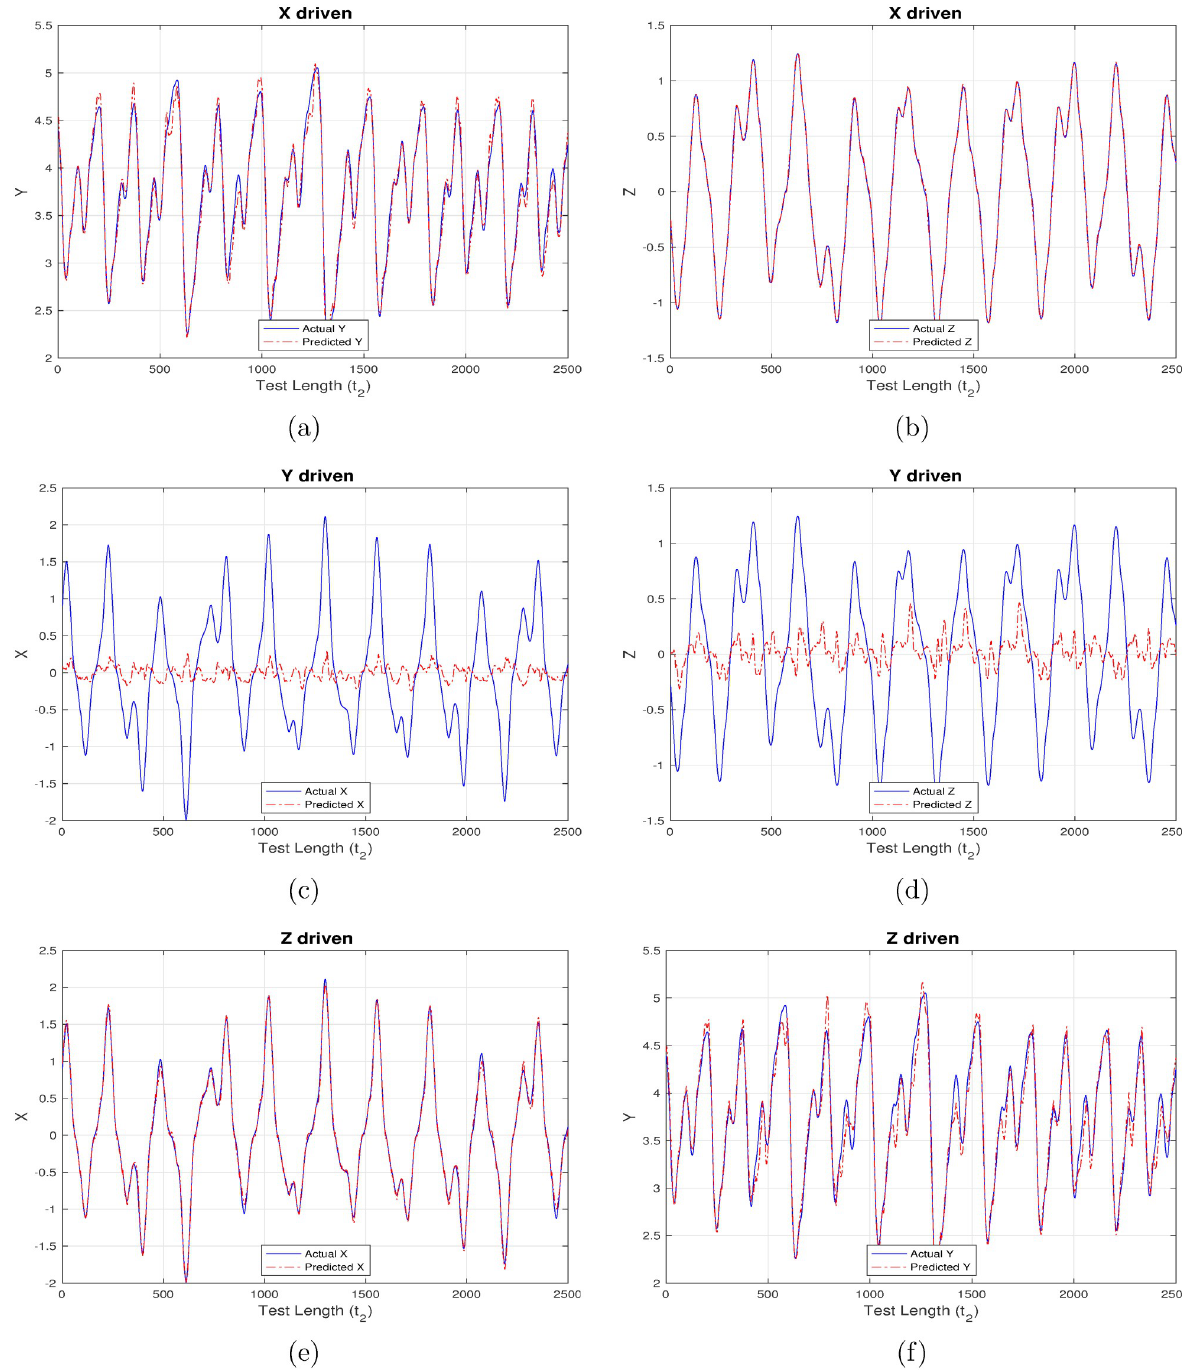
Fig 7. Chaotic financial system component re-generation using “tanh” activation. (a) Re-generating “investment demand” [Y] behavior with “interest rate” [X] as input (b) Re-generating “price index” [Z] behavior with “interest rate” [X] as input (c) Re-generating “interest rate”[X] behavior with “investment demand”[Y] as input (d) Re-generating “price index” [Z] behavior with “investment demand” [Y] as input (e) Re-generating “interest rate” [X] behavior with “price index” [Z] as input (f) Re-generating “investment demand” [Y] behavior with “price index” [Z] as input.